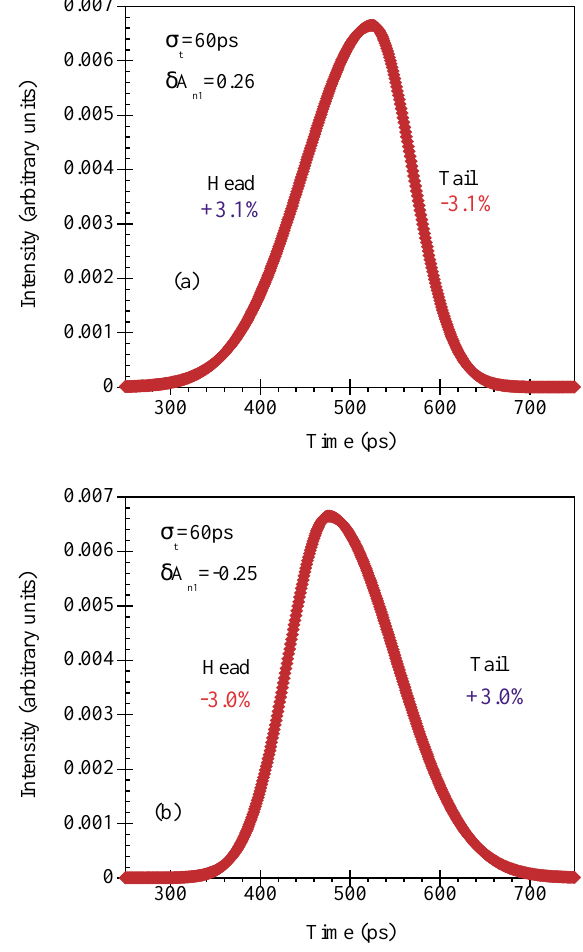
FIG. 21. (Color) The change in the trailing bunches in a train (from a Gaussian distribution) due to a (a) 100 ps deviation and (b) 2 100 ps deviation from the lead bunch in the